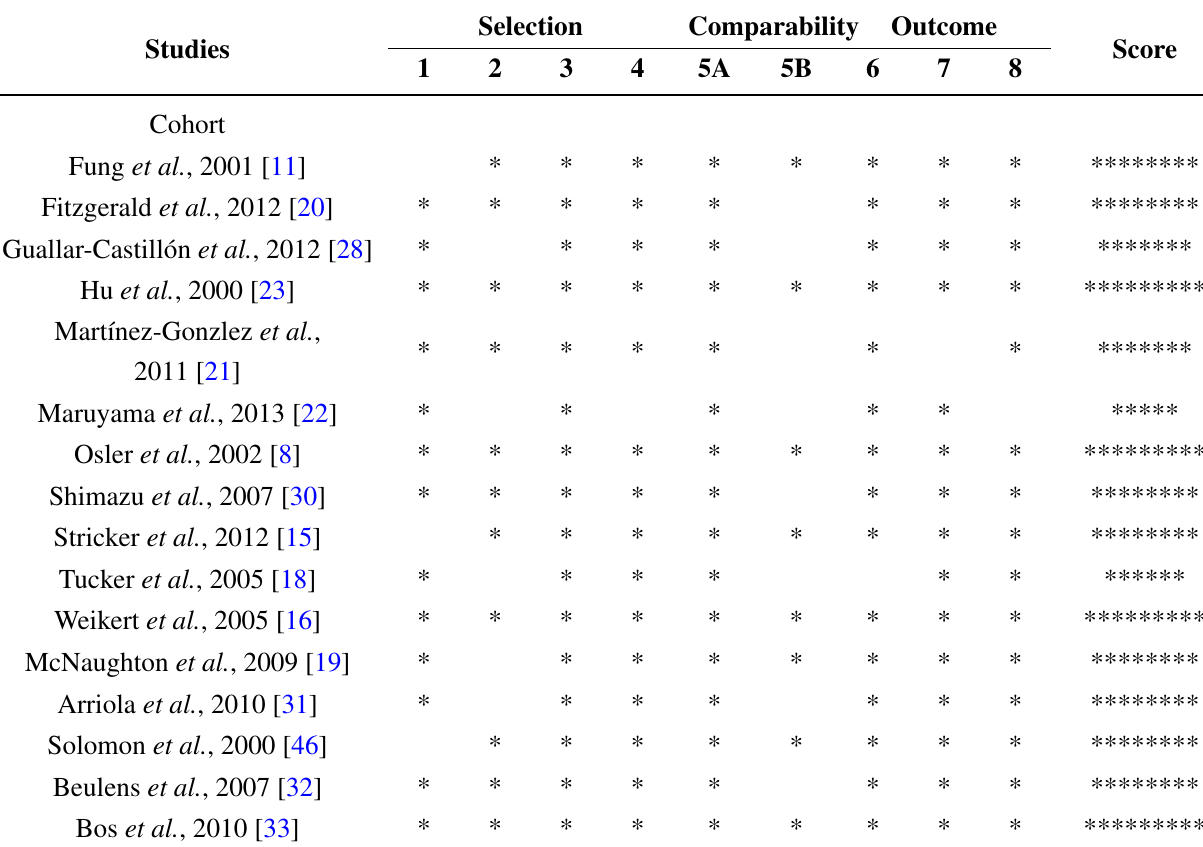
Table B1. Assessment of study quality.